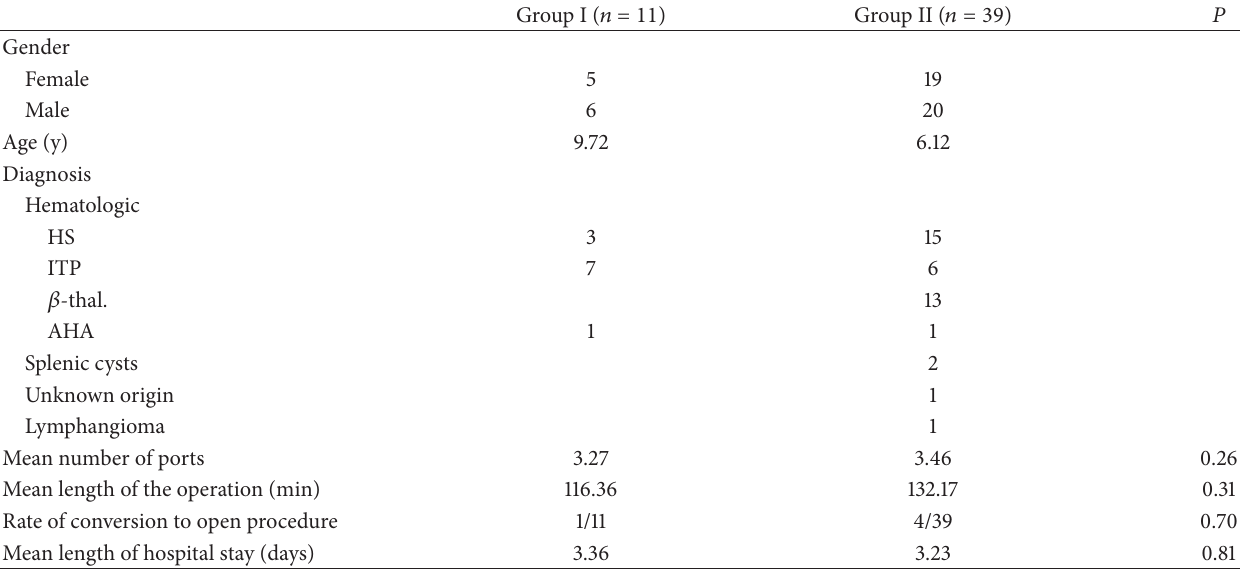
Table 2: The comparison of patients in Group I (patients with normal sized spleens) and Group II (patients with splenic lengths exceeding the upper limits based on the patients’ ages) in terms of patients’ demographic data, the number of ports, operation time, rate of conversion to an open procedure, and length of hospital